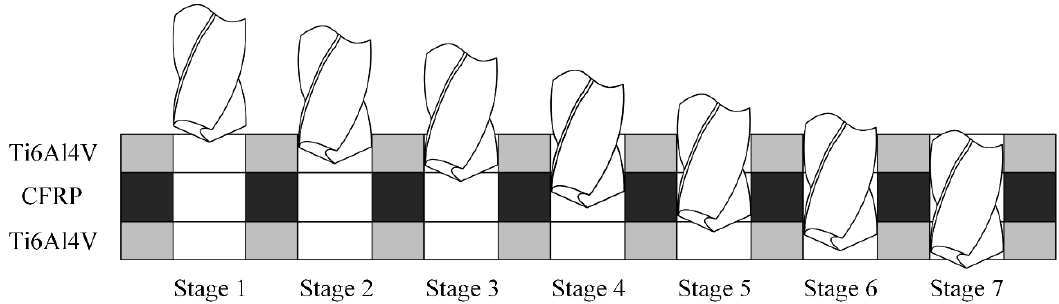
Figure 1. Seven stages of drilling Ti-CFRP-Ti laminated stacks.